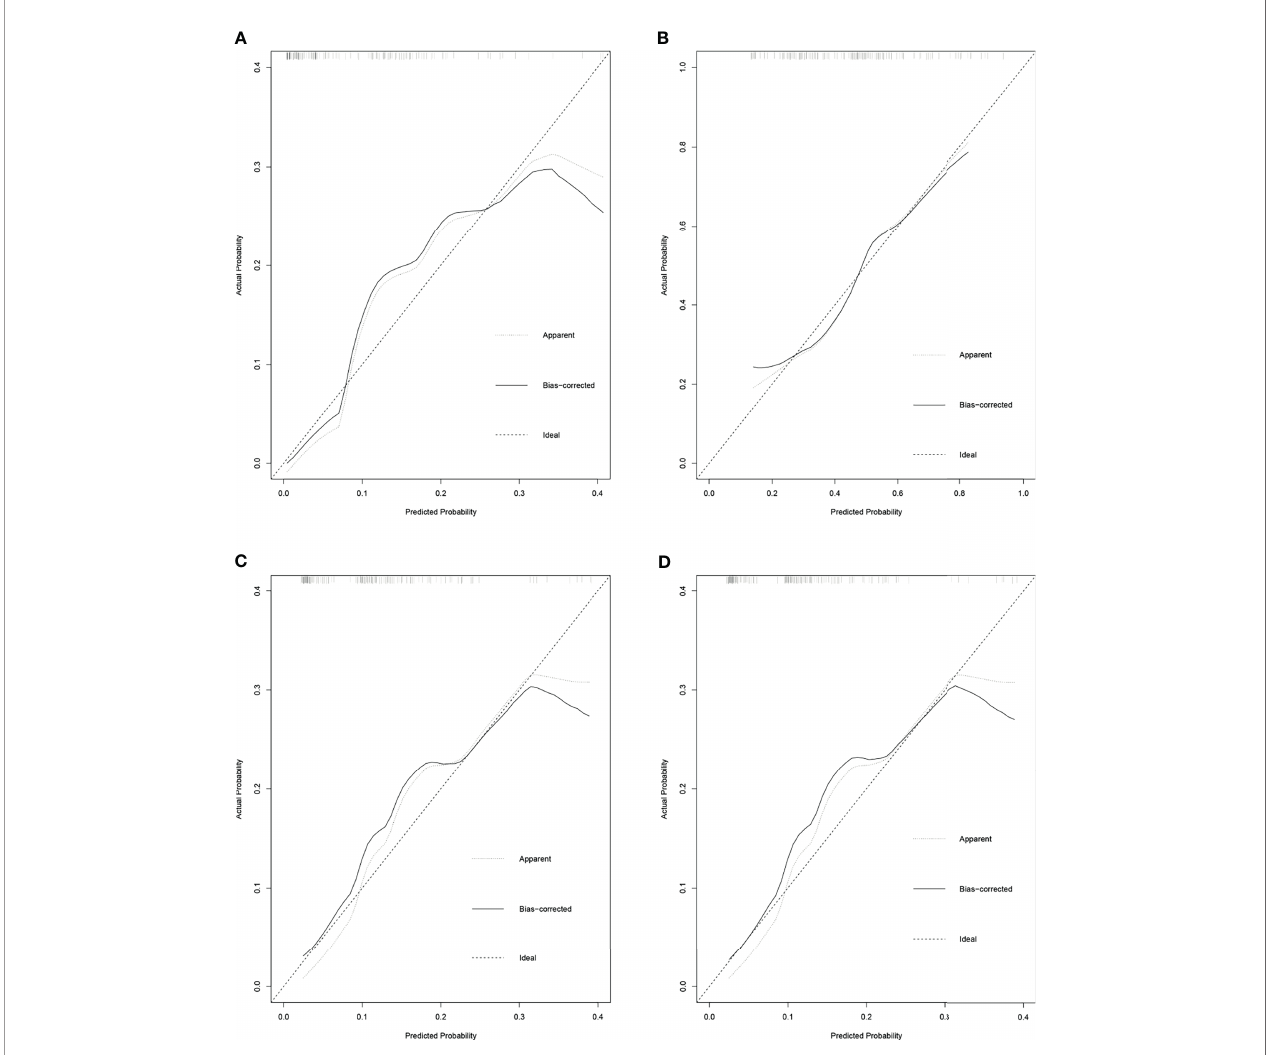
FIGURE 2 | The calibration curves for the prediction nomograms of unfavorable pathological types intravesical recurrence following radical nephroureterectomy (RNU). (A) Calibration curves for the prediction nomograms of muscle-invasive bladder cancer (MIBC) after RNU. (B) Calibration curves for the prediction nomograms of high-grade bladder cancer (HGBC) after RNU. (C) Calibration curves for the prediction nomograms of bladder cancer >3 cm after RNU. (D) Calibration curves for the prediction nomograms of MIBC and/or HGBC after